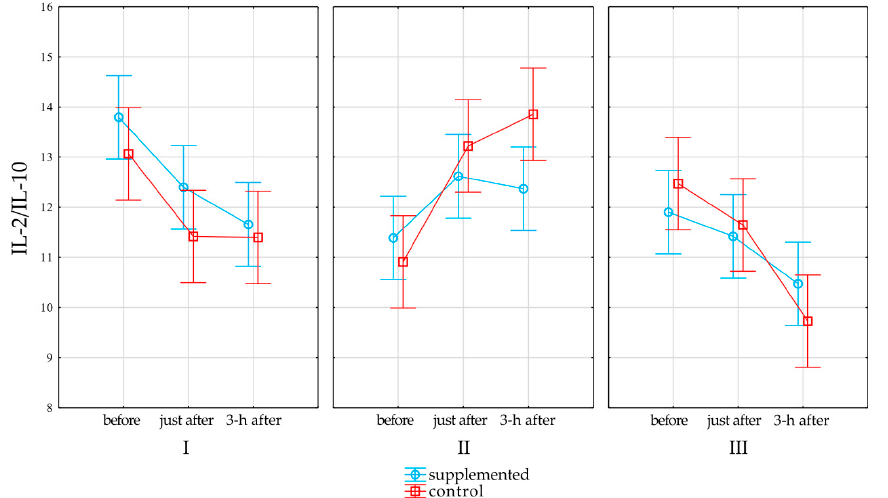
Figure 3. Effects of supplementation on IL-2/IL-10. Red line denotes changes in the control group, and light blue line denotes changes in the supplemented group. Whiskers denote standard error, while open rectangles for the control group and open circles for the supplemented group denote mean value.